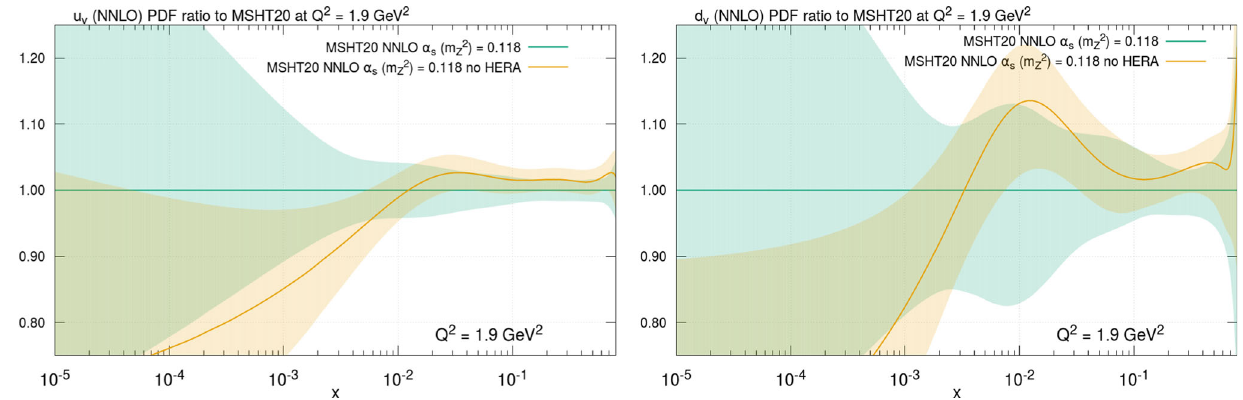
Fig. 72 (Left) u V PDF and (right) d V PDF ratios to the MSHT20 default at Q 2 = 1 . 9 GeV 2 at NNLO showing the effect of removing the HERA data from the MSHT20 default global fit